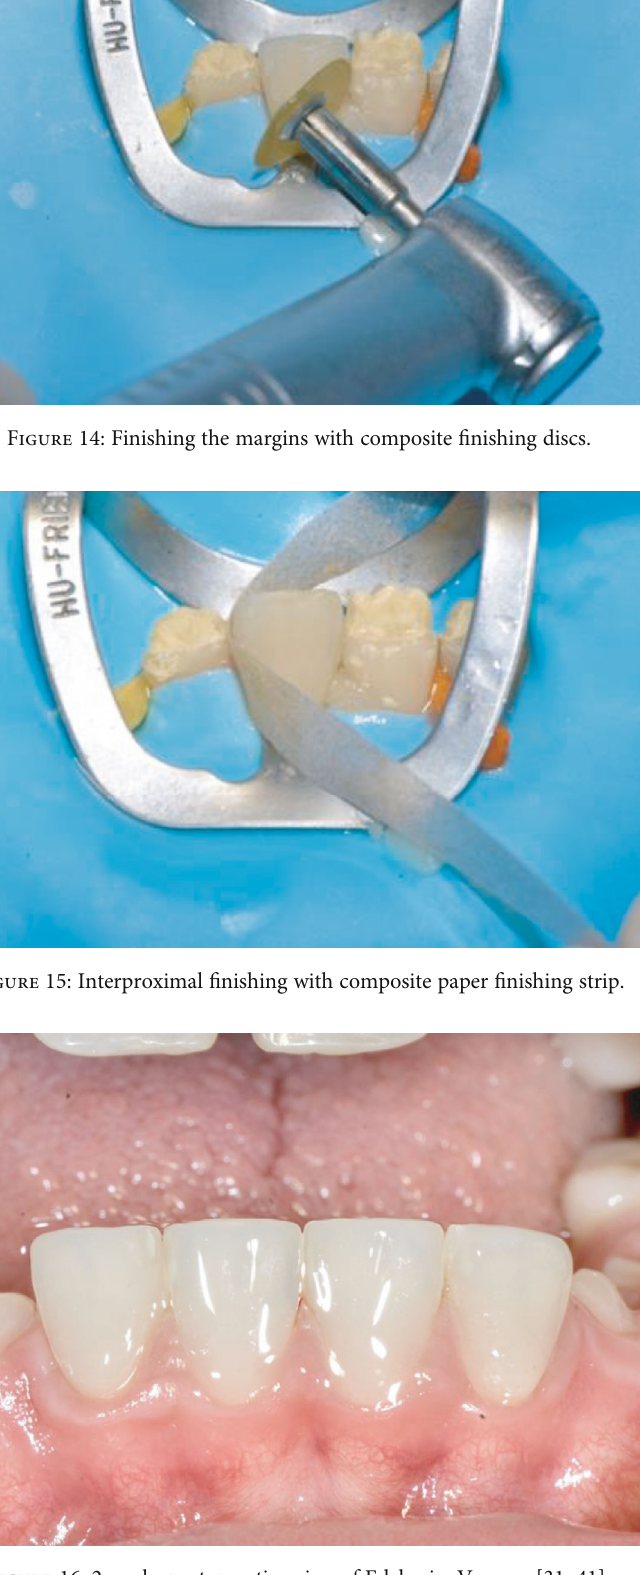
Figure 16: 2 weeks postoperative view of Edelweiss Veneers [31 –